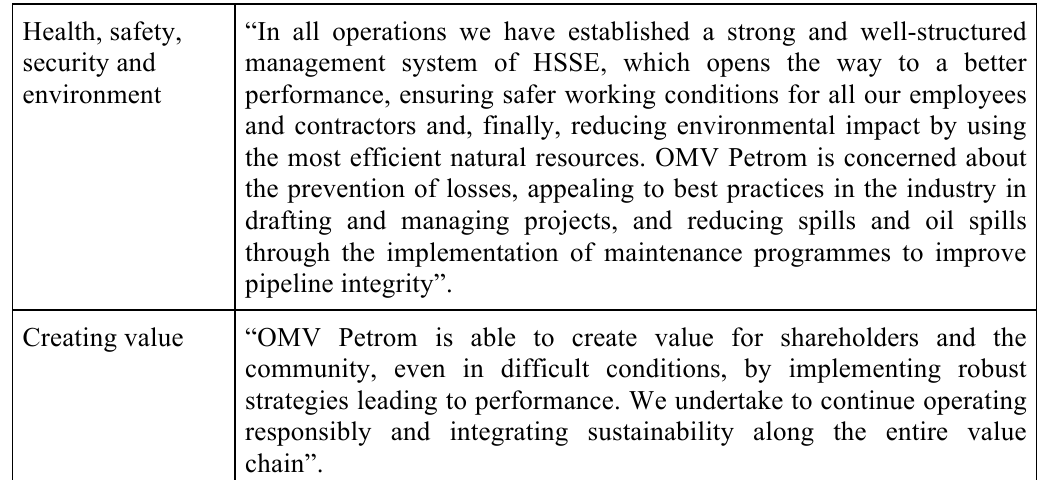
Table 5: Geico Taikisha and OMV Petrom Leadership